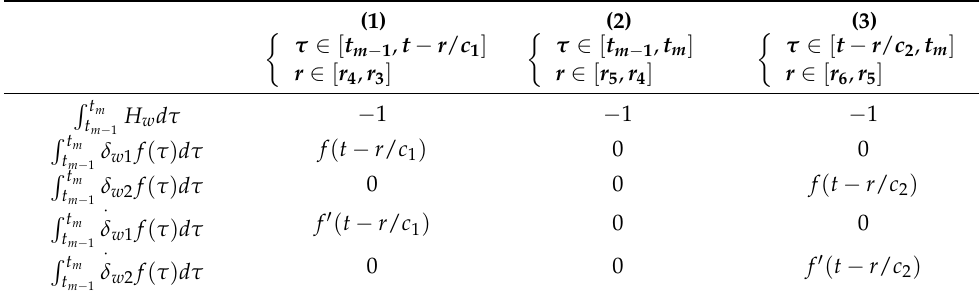
· · δ w 1 and δ w 2 in time element [ t m − 1 , t m ] in the case of